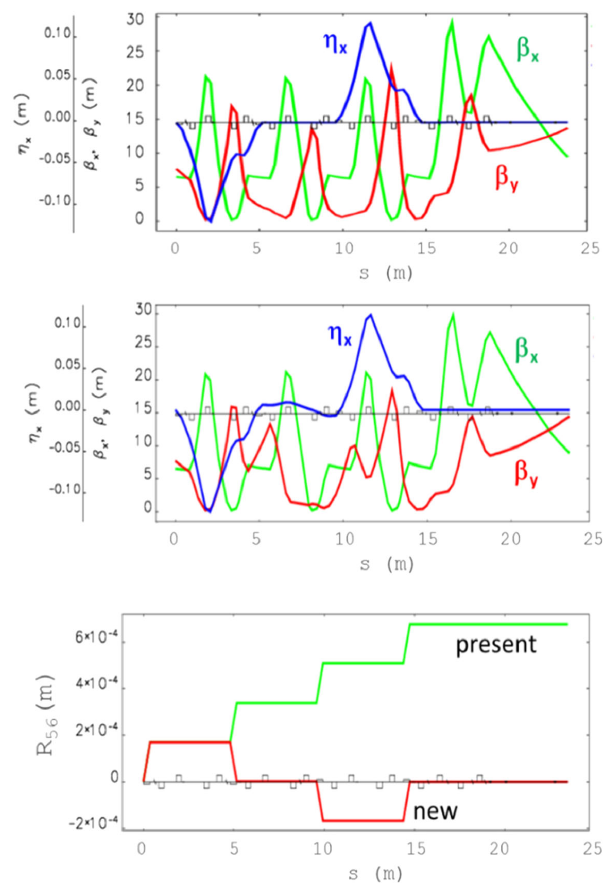
FIG. 7. Gain (top) and energy modulation amplitude (bottom) at the end of the FERMI linac (green) and linac-plus-spreader beam line (black), for the new spreader optics. The laser heater is set at 10 keV rms energy spread before compression. The bunching factor (not shown) grows up to 0.2 in the wavelength range 10 – 50 μ m. Please compare with Fig.